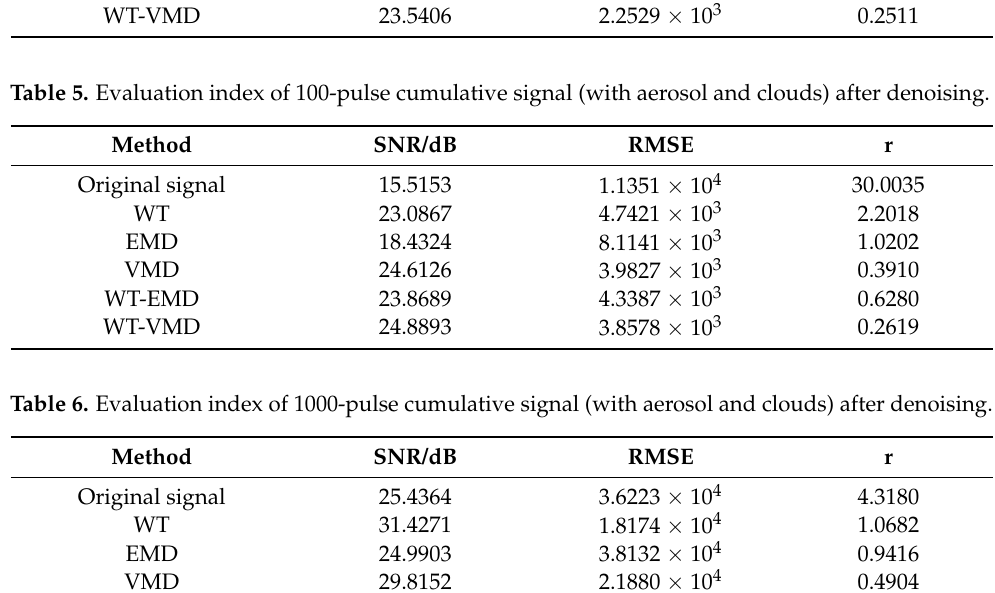
and clouds): ( a ) original signal; ( b ) WT; ( c ) EMD; ( d ) VMD; ( e ) WT-EMD; ( f ) WT-VMD.